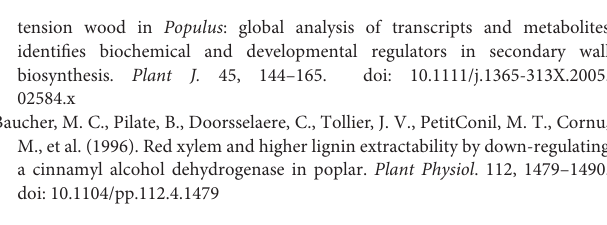
Supplementary Figure 2 | The KEGG pathway enrichment of differentially expressed genes (DEGs) and differentially expressed proteins (DEPs). Gray indicates missing values. Supplementary Figure 3 | Differentially expressed genes (DEGs) and Differentially expressed proteins (DEPs) involved in the lignin monomer synthesis pathways in tension wood (TW) vs. opposite wood (OW) and TW vs. normal wood